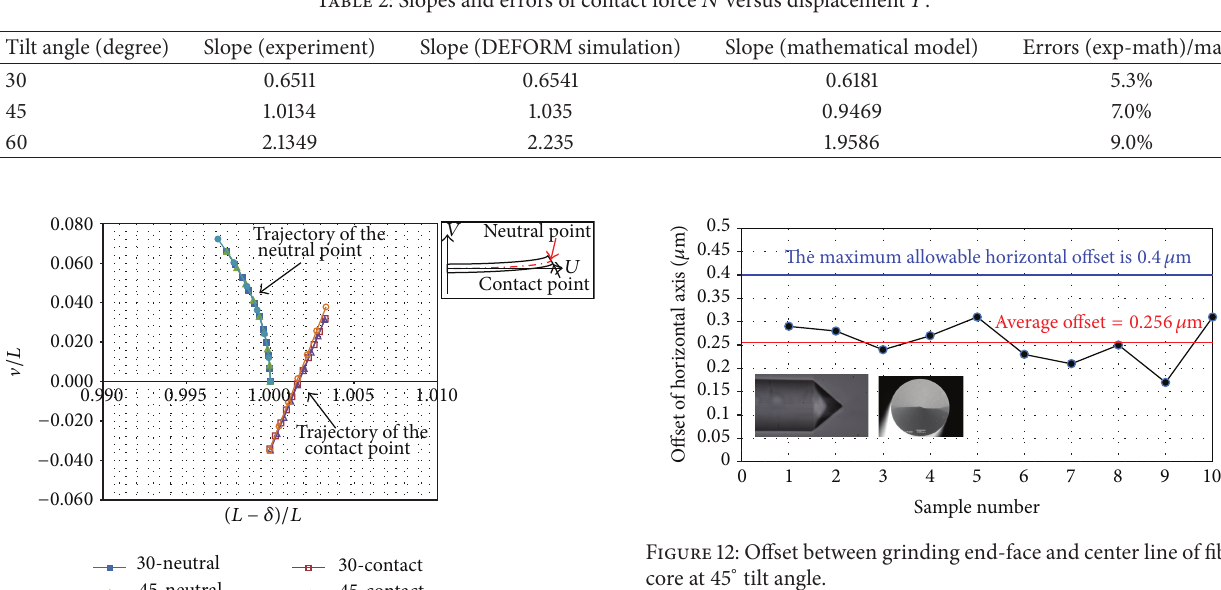
7.0%, and 9.0% for tilt angles of 30 ∘ , 45 ∘ , and 60 ∘ , respectively. (iii) The horizontal axis offsets between the fiber core and end-face were successfully controlled within 0.15 to 0.35 𝜇 m. The average offset of horizontal axis was 0.26 𝜇 m.